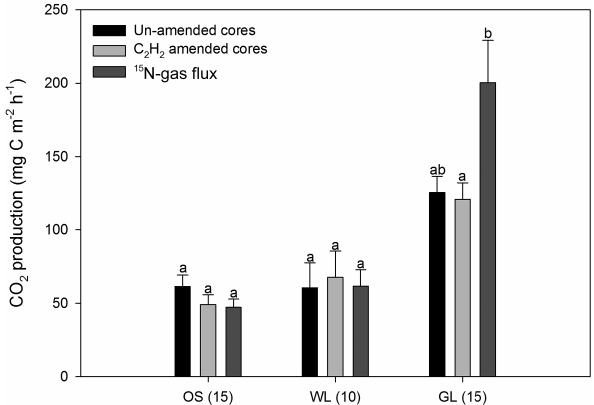
Figure 6. Mean CO 2 production measured in the static chambers of the 15 N gas-flux method, in un-amended and C 2 H 2 amended intact soil cores in the three land use types (OS: organic soils; WL: wood- land; and GL: grassland). Same lower-case letters indicate no sig- nificant differences ( p >0.05) between measurement methods ac- cording to an independent samples t test. The sample size ( n ) is given in parentheses for each land use type on the x axis. Error bars represent standard